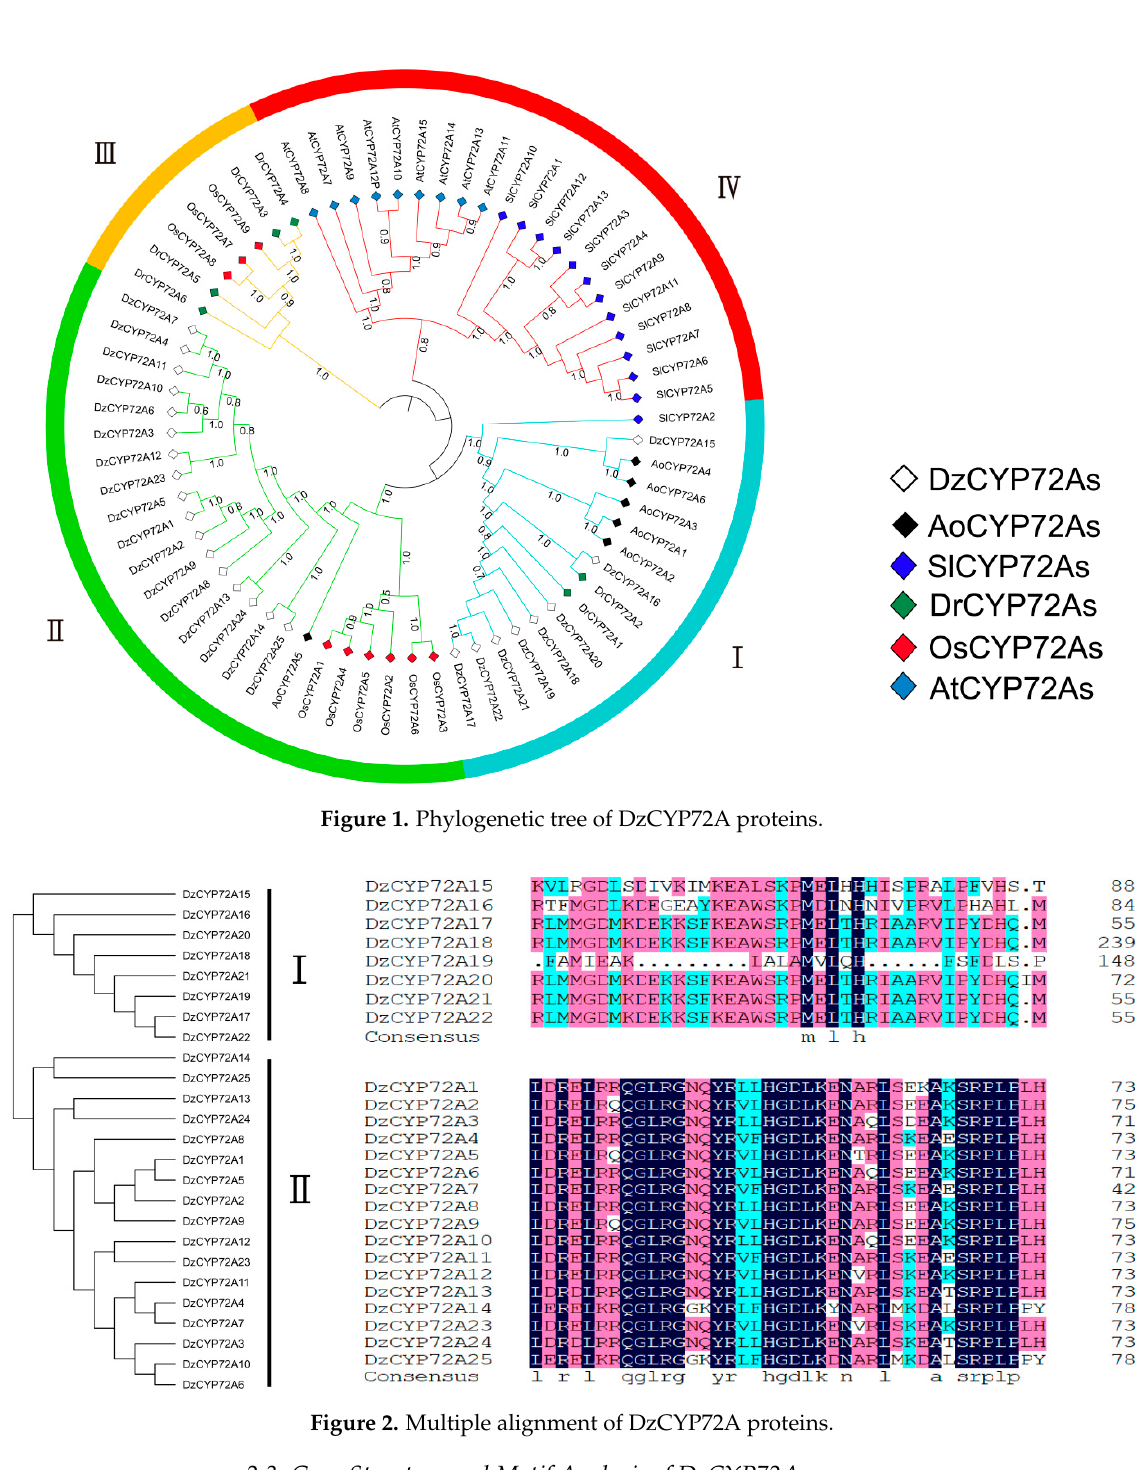
Figure 2. Multiple alignment of DzCYP72A proteins.